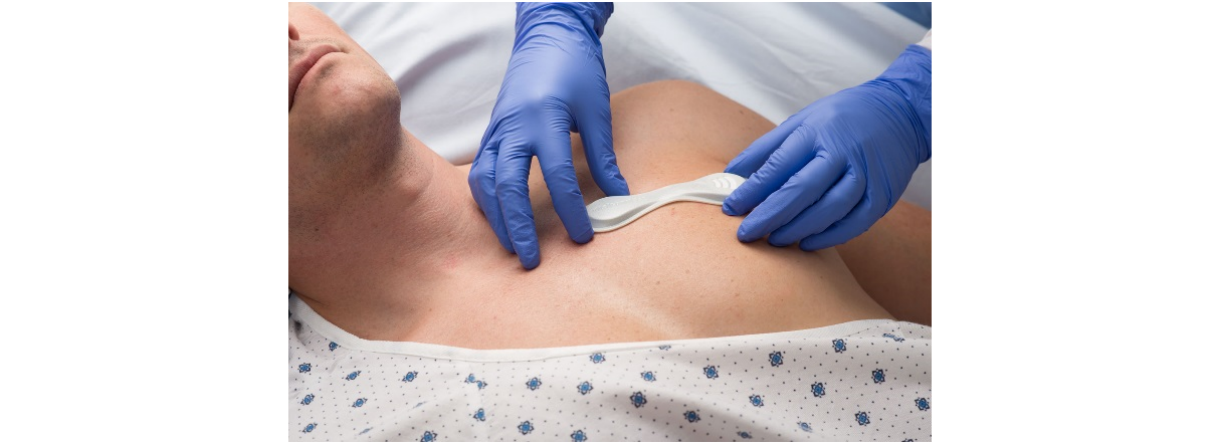
Figure 2. VitalPatch